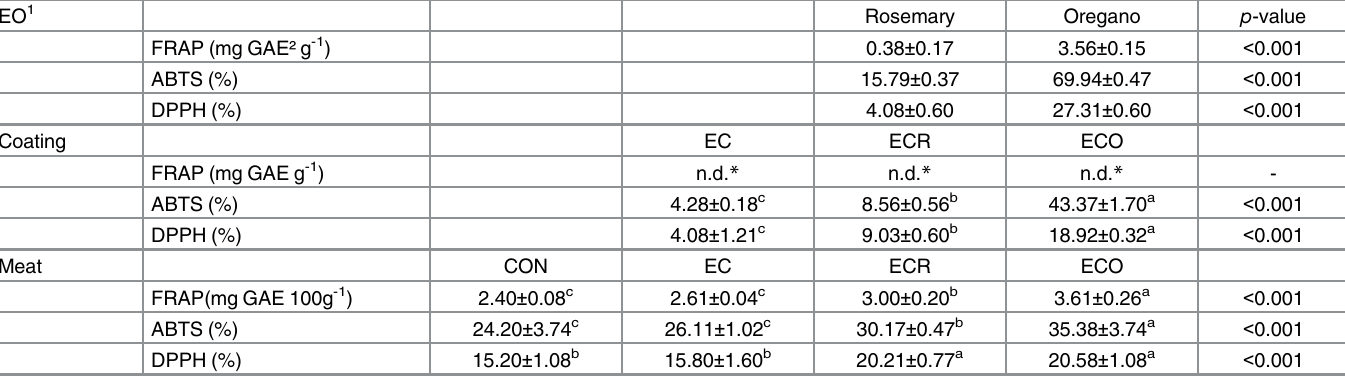
Means with different lowercase letters in the same line are signi fi cantly different ( p <